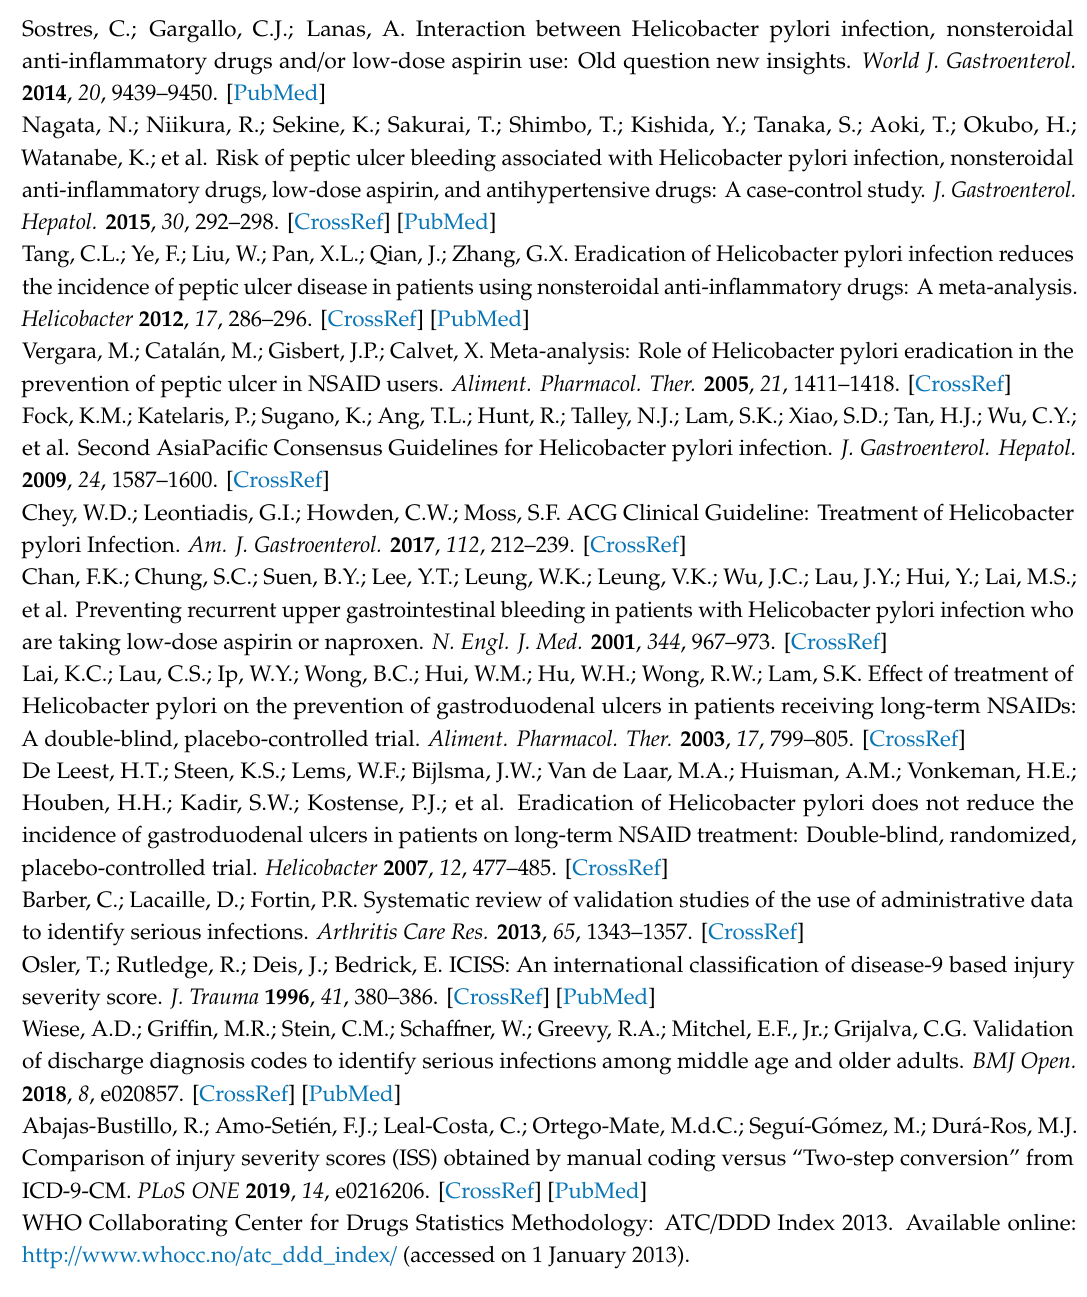
Table S1: Summary of Helicobacter pylori treatment